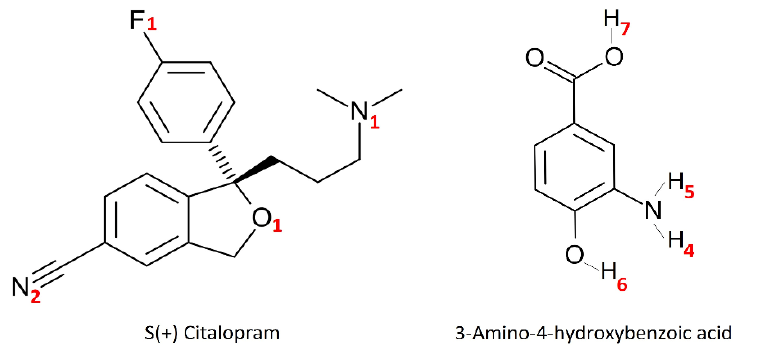
Figure 1. Schematic representation of S(+) citalopram, CTL with the chiral center indicated, and 3-amino-4-hydroxybenzoic acid (AHBA), along with some atom types, used throughout this work.